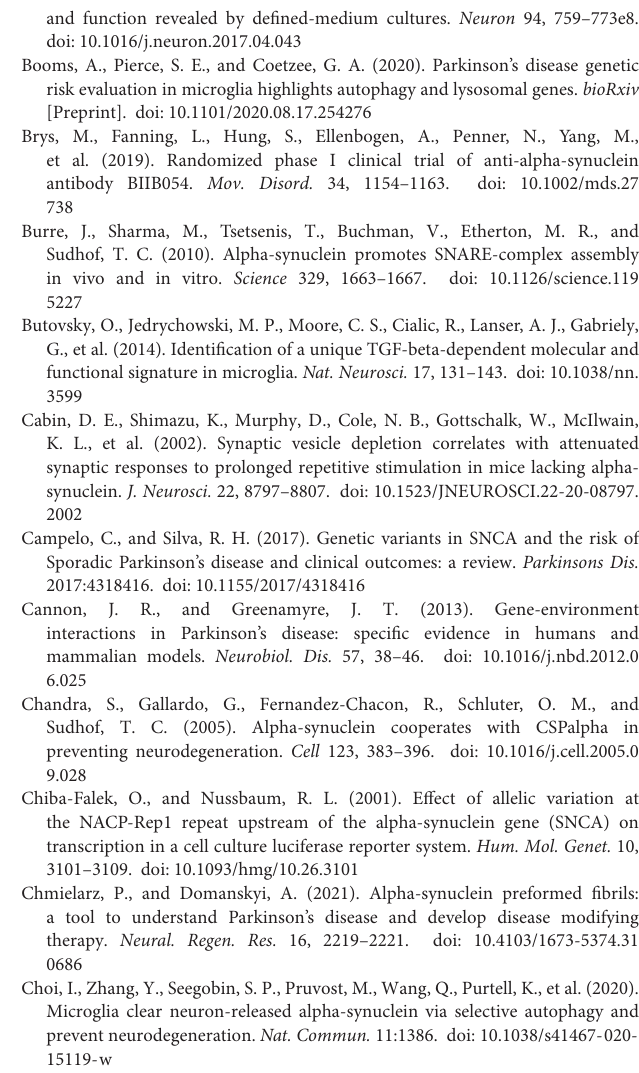
Supplementary Table 1 | PD risk SNPs at the SNCA locus. The SNPs listed in this table were determined to be associated with PD risk by Nalls et al. (2019). The one that we believe to be relevant to microglia function, based on its location in open regulatory DNA (marked using ATAC- and H3K27ac-seq; Booms et al., 2020), is highlighted in yellow. IUPAC codes are listed at the